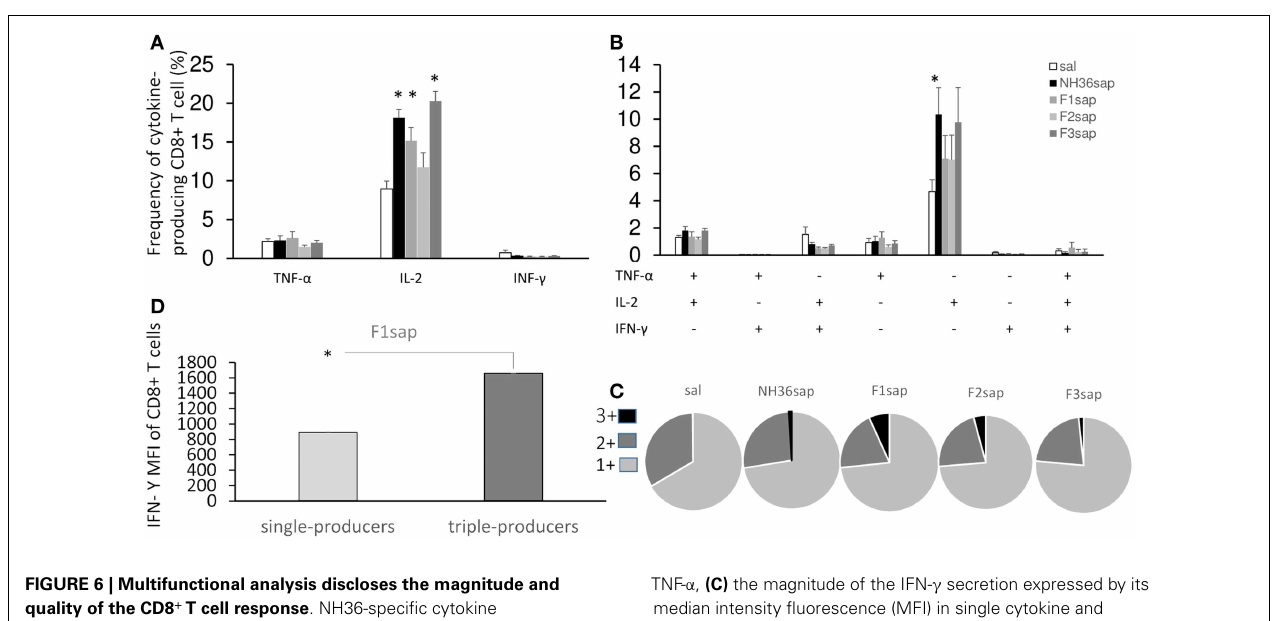
FIGURE 6 | Multifunctional analysis discloses the magnitude and quality of the CD8 + T cell response . NH36-specific cytokine production from CD8 + T cells of spleens of immunotherapy treated and control mice 9weeks after infection (A–C) . Multiparameter flow cytometry was used to determine (A) the total frequency of IFN- γ -, IL-2-, orTNF- α -producing CD8 + T cells, (B) the frequency of cells expressing each of the seven possible combinations of IFN- γ , IL-2, and